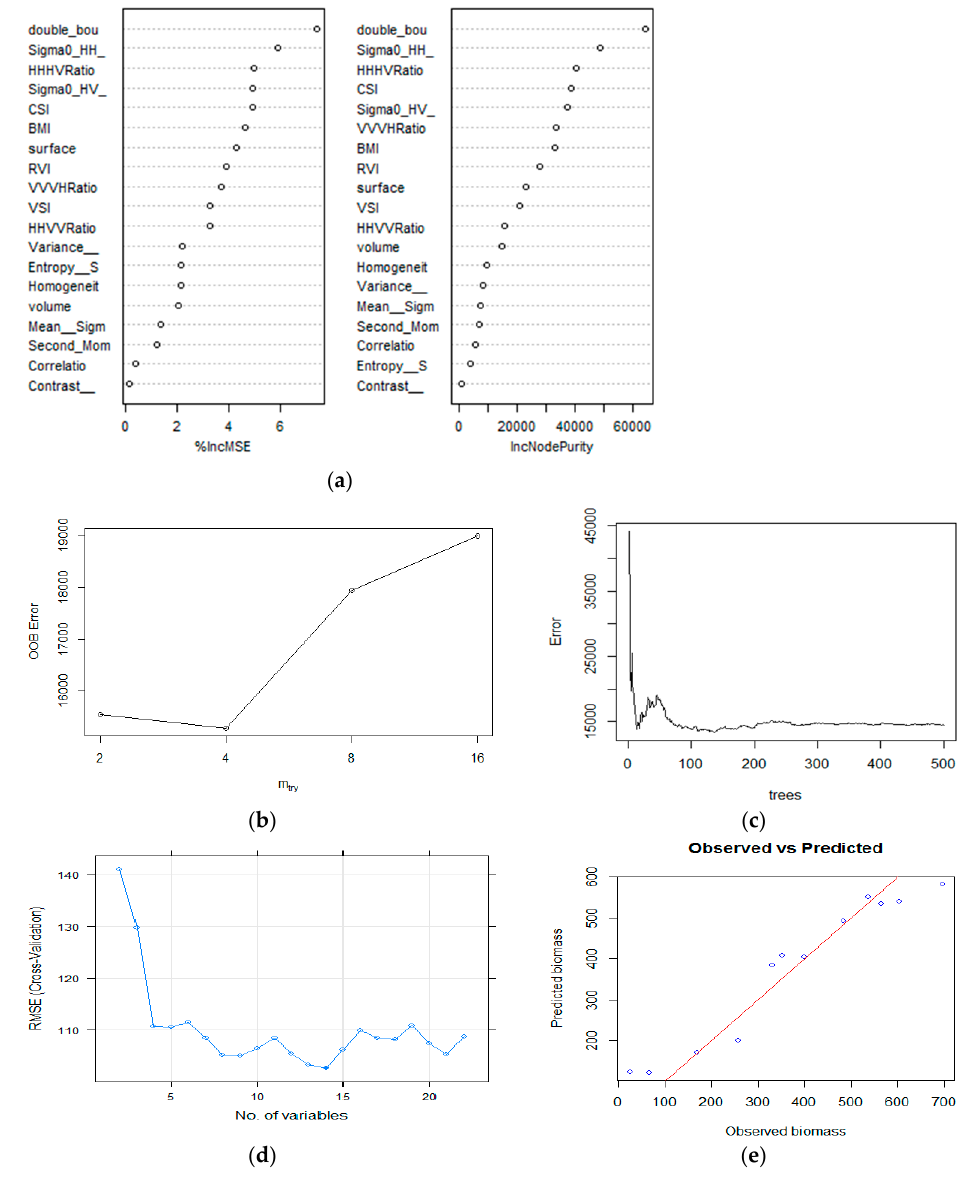
Figure 10. Visualization of ( a ) % IncMSE and IncNodePurity of the variables used to train the model;